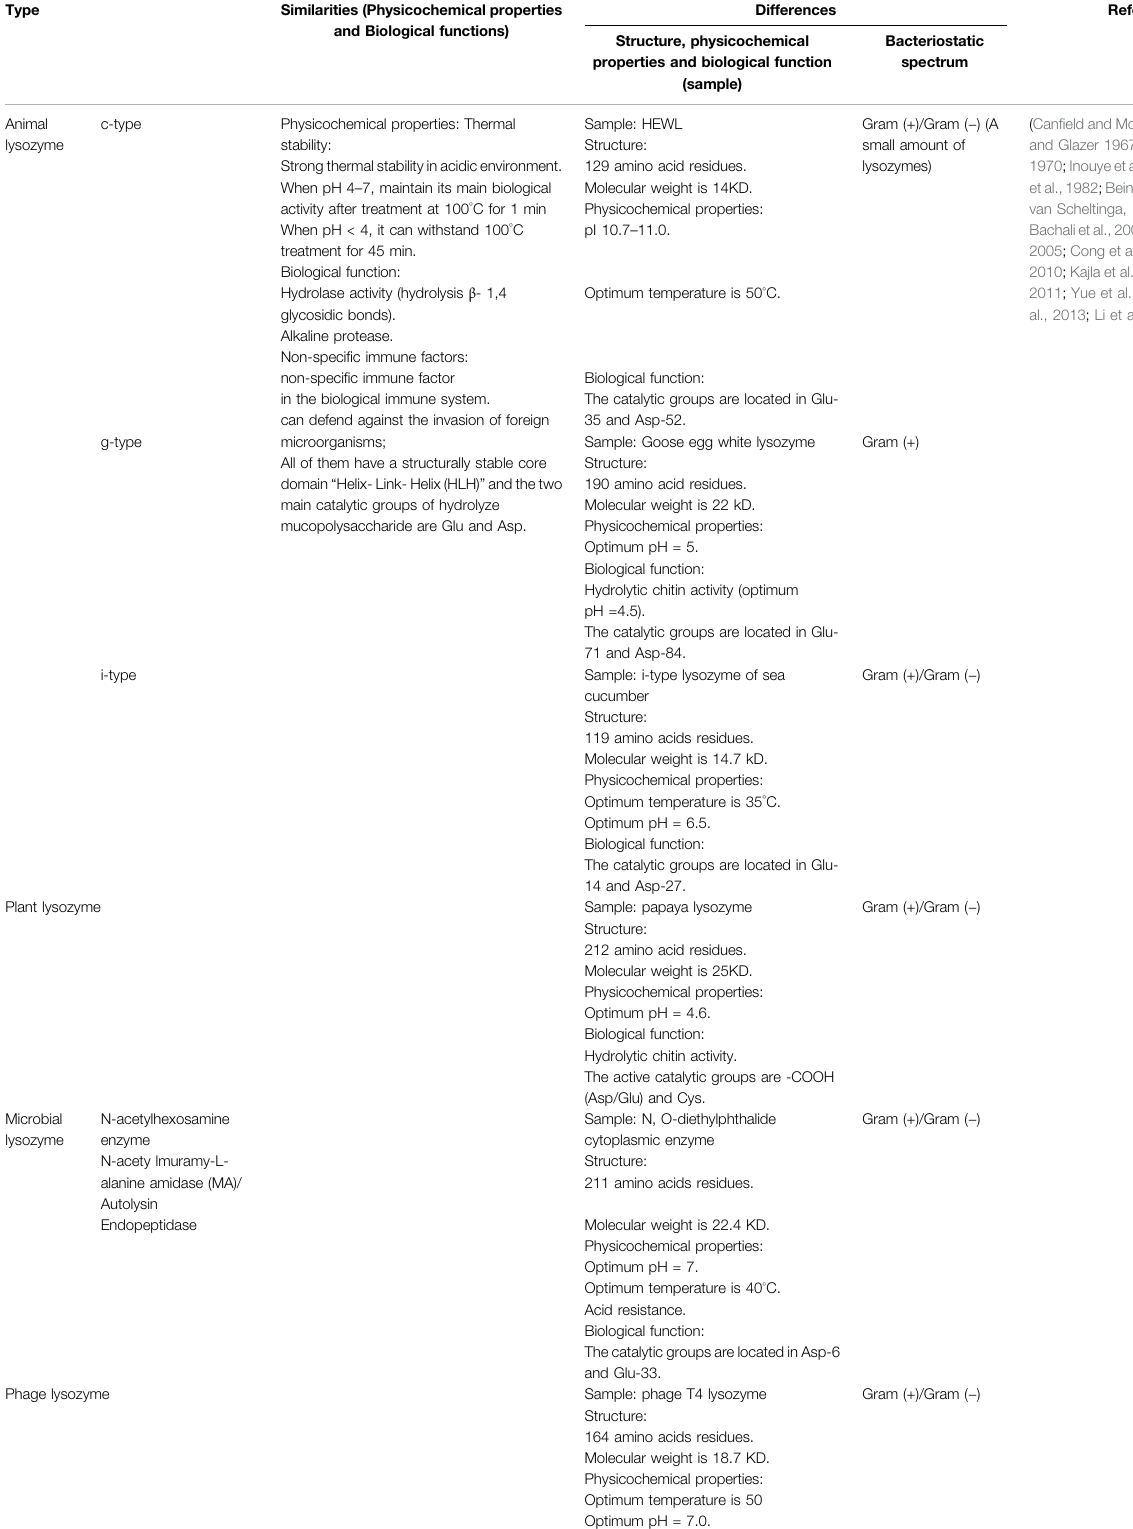
TABLE 1 | The similarities and differences between animal- and plant-original